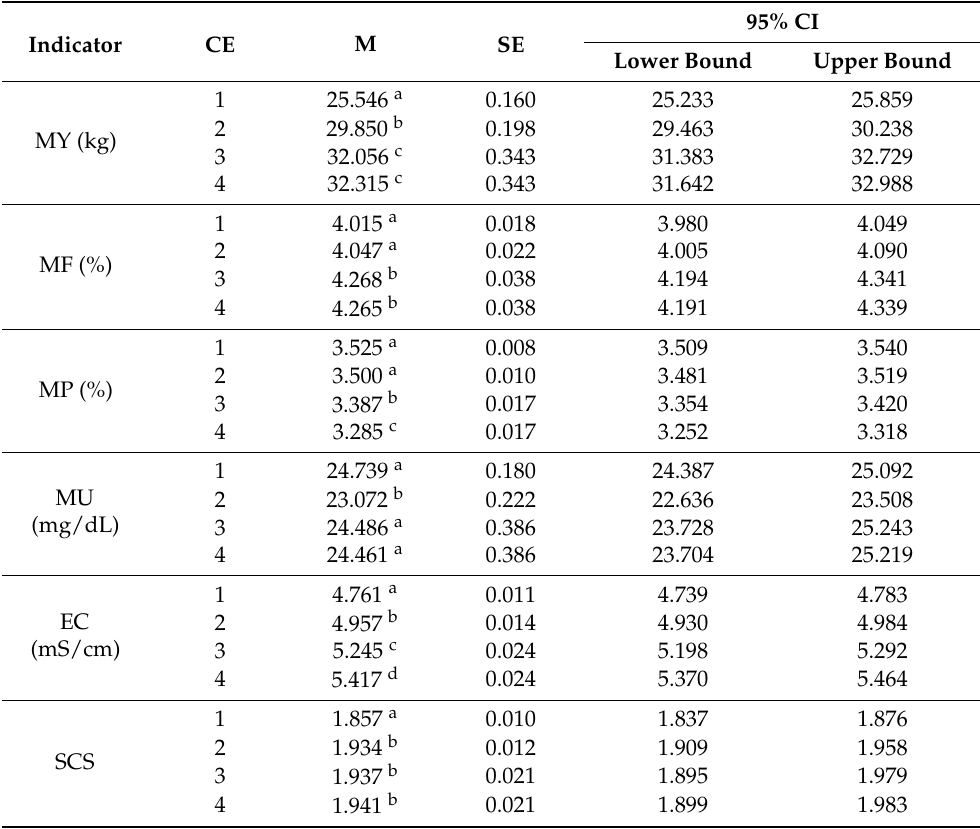
Figure 3. Milk lactose correlation with other milk traits. EC = electrical conductivity of all quarters of the udder; SCS = somatic cell score calculated as log2(number of somatic cells/100) + 3; MP = milk protein; MF = milk fat; MY = milk yield. Table 3. Milk traits by calving